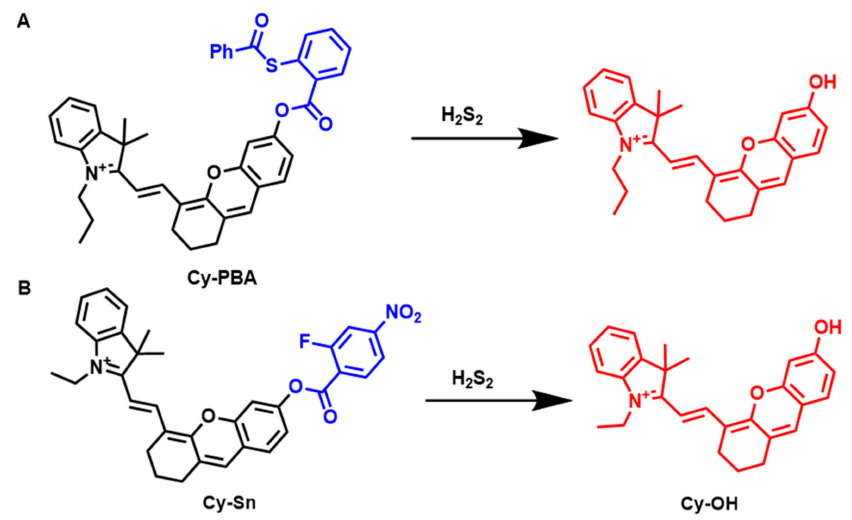
Figure 11. The response mechanisms and chemical structures ( A ) Cy-PBA and ( B ) Cy-Sn of fluores- cent probes for H 2 S 2